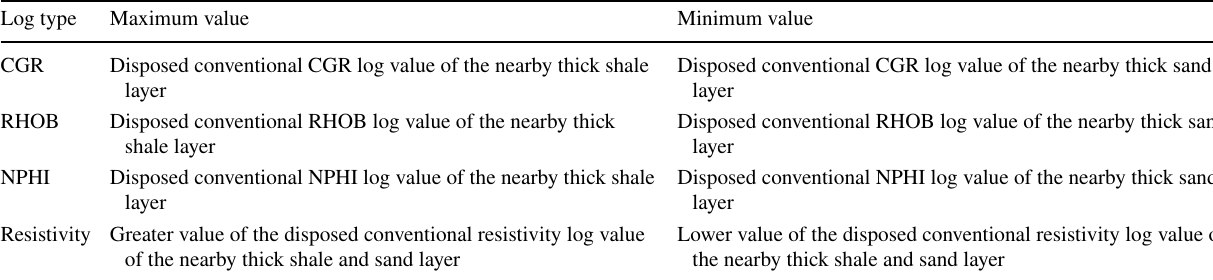
The value of resistivity log of the sand and shale layers in the LSS is depended to the filled fluid saturation of those layers. Resistivity of the shale and sand according to their saturation can be maximum or minimum. The resistivity log of the thick shale and sand layer of the near LSS sequences is read from disposed conventional log and then the greater value is put as maximum and the lower value is put as minimum con- straints of the resistivity log For obtaining the final reliable results with less iterations, these constrains should